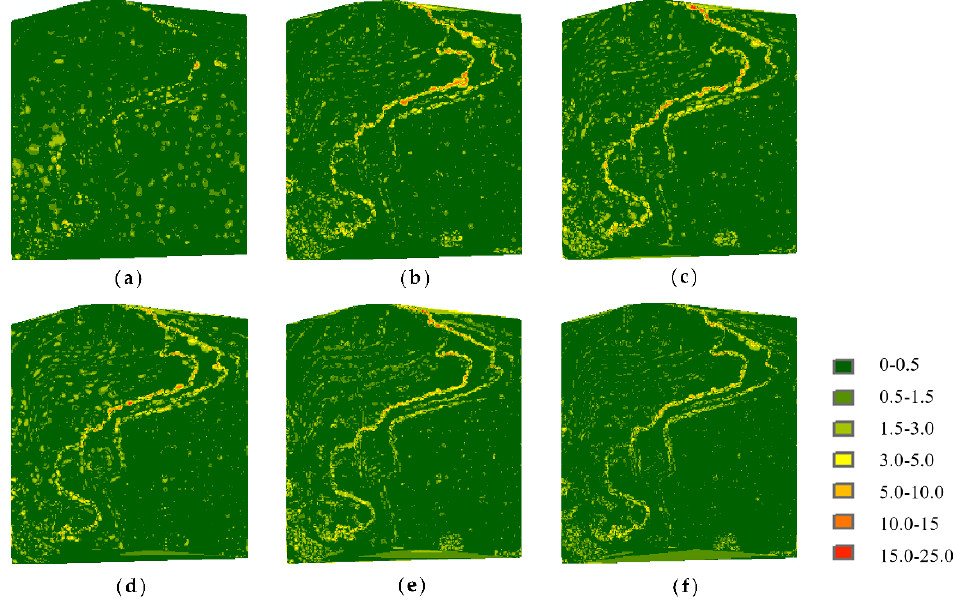
Figure 10. Elevation difference distributions of Samp52: ( a ) MIWSA; ( b ) random algorithm; ( c ) normal algorithm; ( d ) voxel algorithm; ( e ) k-means algorithm; ( f ) curvature algorithm.